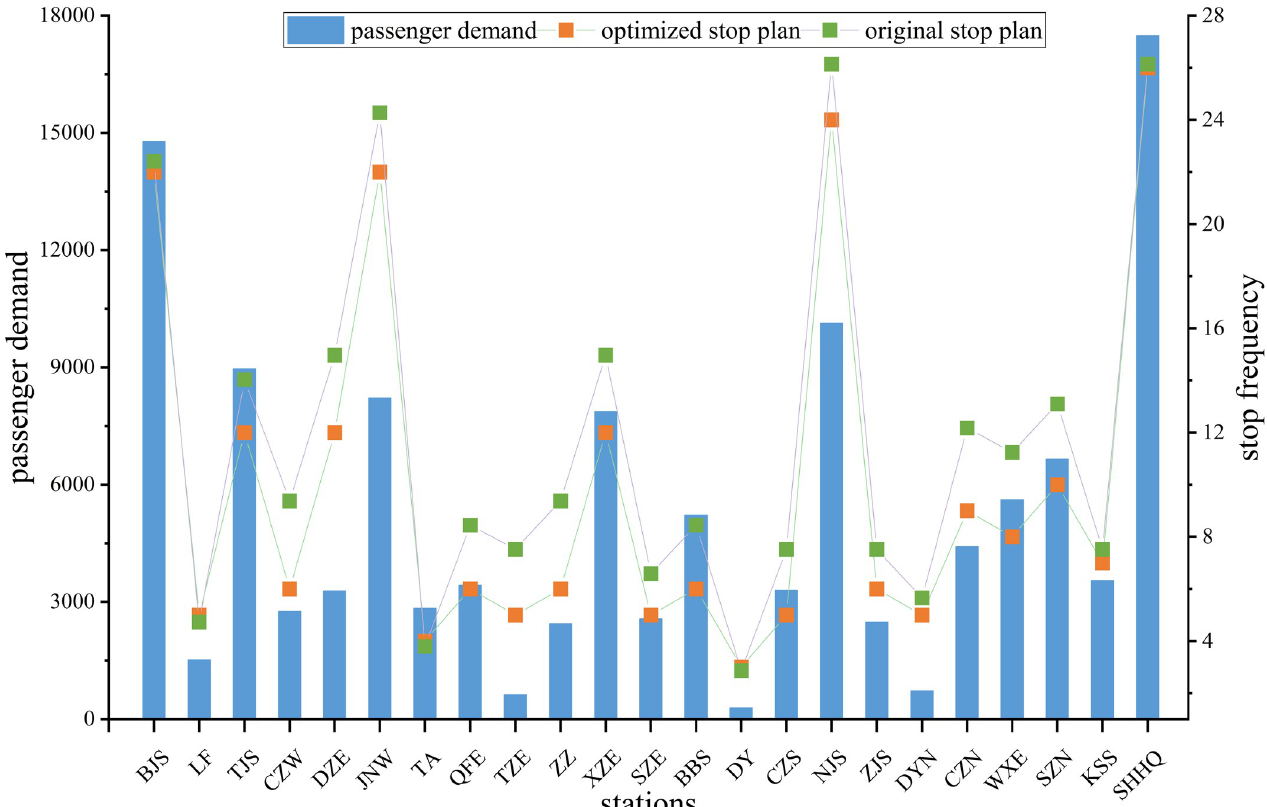
Fig 8. Changes in the frequency of stops at each station and the connection with passenger flow.